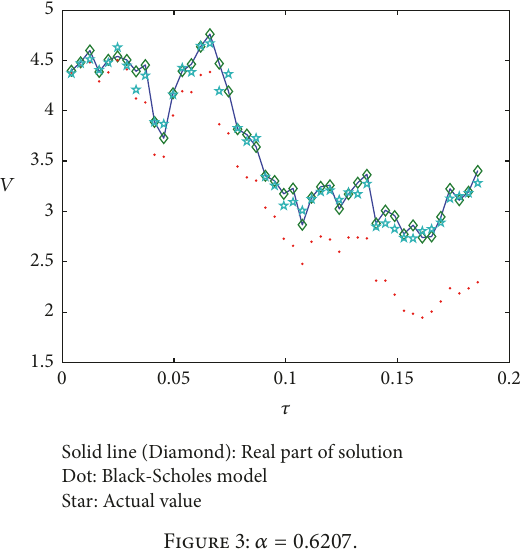
Figure 3: 𝛼 = 0.6207 .